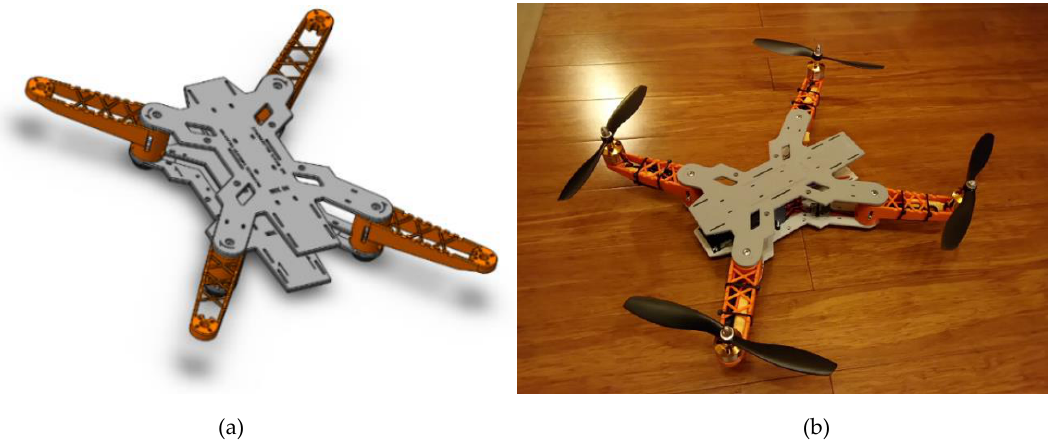
Figure 3. ( a )—The 3D model of a quadcopter frame design [5], ( b )—fully assembled Figure 3. ( a ) — The 3D model of a quadcopter frame design [5], ( b ) — fully assembled quadcopter.